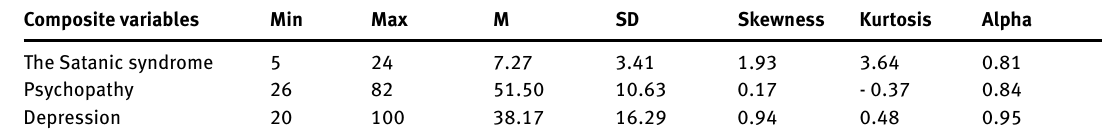
Table 1. Descriptive statistics of total scores on the composite variables of the Satanic syndrome, psychopathy, depression, and Cronbach alpha coefficients